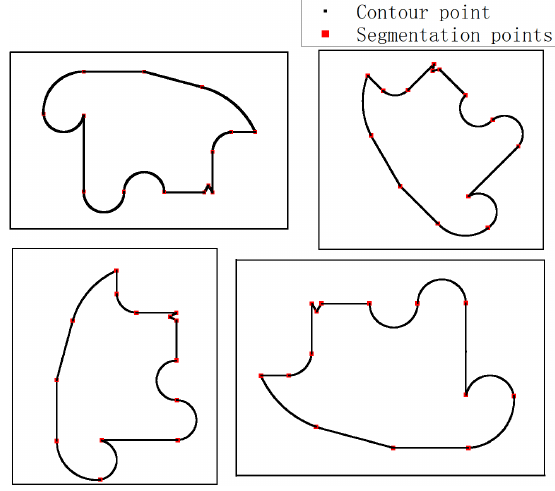
Figure 23. Segmentation points selected from different placement angles.